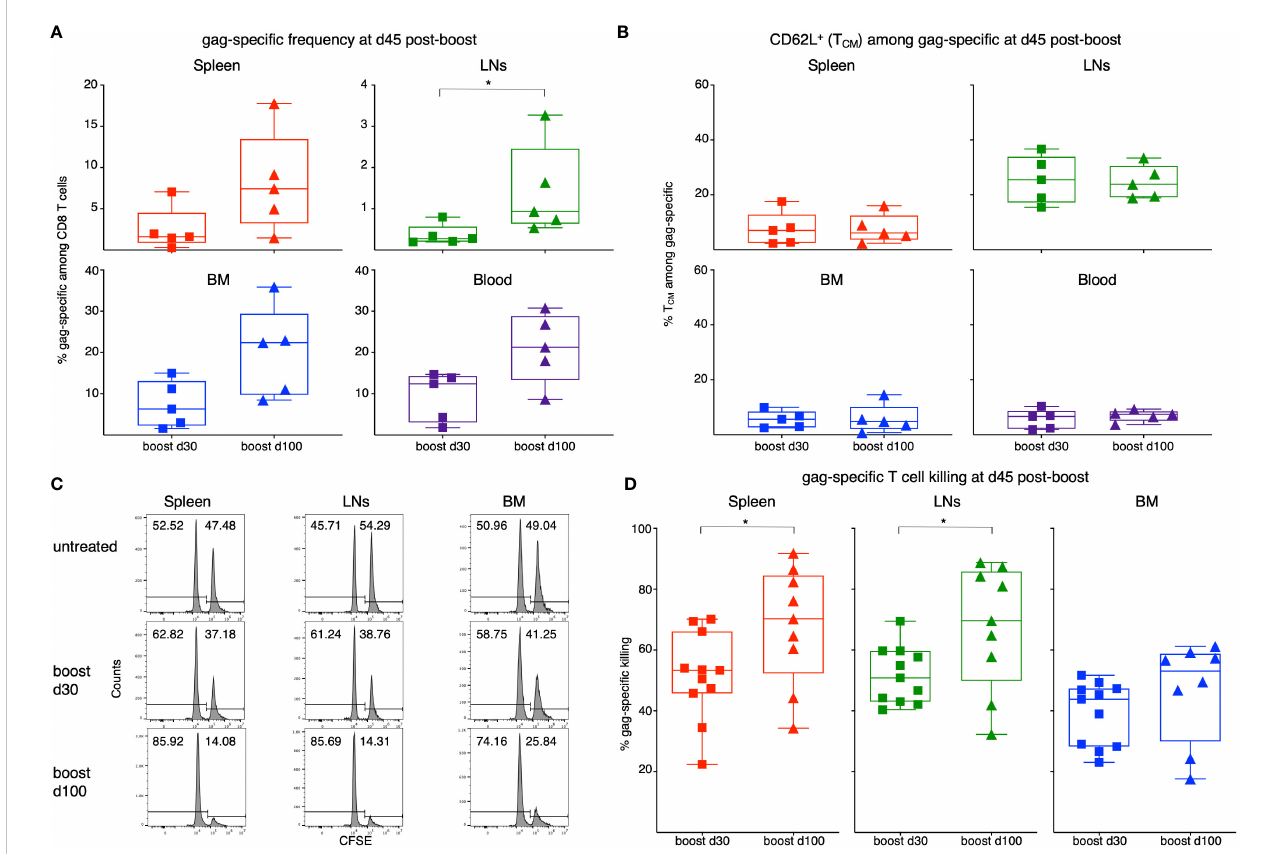
FIGURE 5 Analysis of gag-speci fi c CD8 T cell frequency, T CM -phenotype and in vivo killing activity at d45 post-boost. Female BALB/c mice were primed as in Figure 1 at d0. One set of primed mice was boosted with MVA-gag at d30 post-prime, and another at d100 post-prime. For each set, analysis was performed at d45 post-boost. (A, B) . Frequency of gag-speci fi c CD8 T cells (A) and percentage of TCM among gag-speci fi c CD8 T cells (B) in spleen, LNs, BM and blood of primed/boosted mice. (C, D) . Primed/boosted and untreated control mice were injected i.v. with a 1:1 mixture of gag-pulsed CFSE high cells and unpulsed CFSE low syngeneic spleen cells (approximately 10x10^6 cells each). After 3 hours, the percentages of CFSE high and CFSE low cells were measured in spleen, LNs and BM, and the percentage of gag-speci fi c killing was determined. Examples of CFSE histograms (C) and